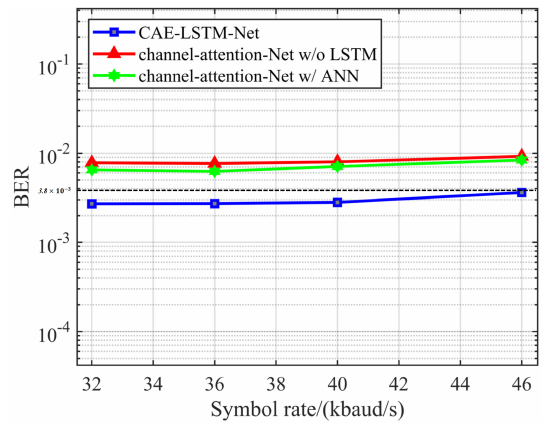
Figure 13. BER performance by using different equalizers.